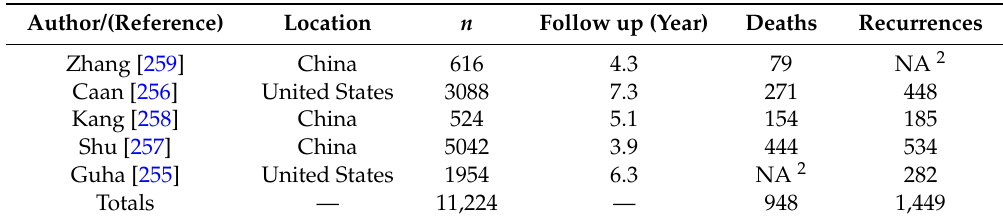
Table 4. Experimental details of prospective epidemiologic studies included evaluating the impact of post-diagnosis soy intake on breast cancer recurrence and survival 1